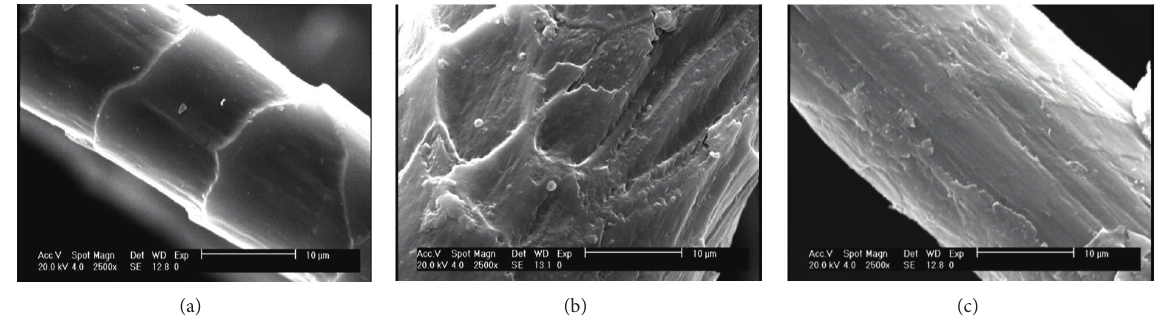
Figure 4: SEM image of wool fiber surface morphology: (a) untreated and (b) 2 and (c) 6 minutes of plasma pretreatment before dyeing procedure.